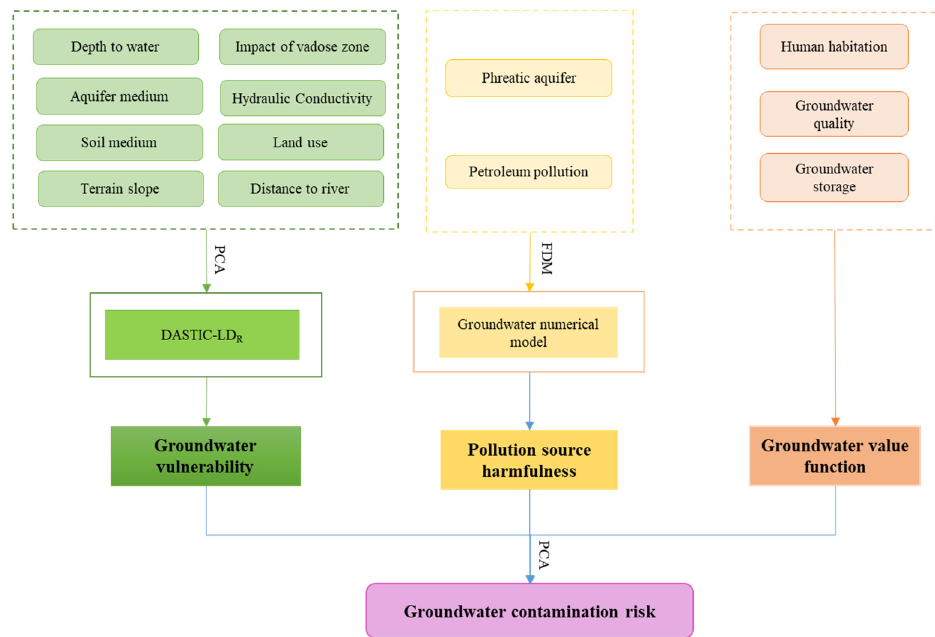
Figure 2. Modeling framework of groundwater pollution risk assessment.